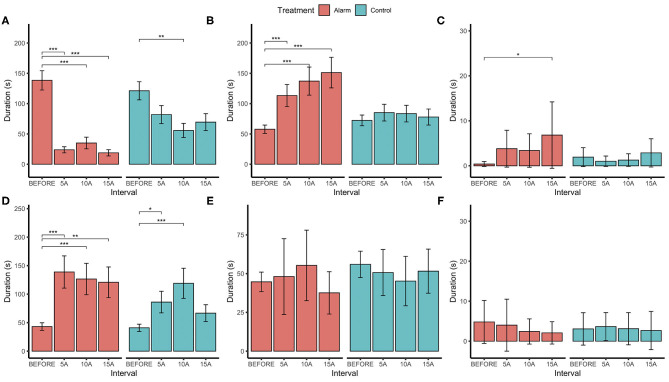
Estimated marginal means (±SE) for durations (in seconds) of (A) activity, (B) stationary, (C) social behaviors, (D) preening, (E) foraging, and (F) brooding behaviors before the stimulus (BEFORE) and in 5-min sample intervals after (5A = 0–5 min; 10A = 5–10 min; and 15A = 10–15 min) for both the alarm exposed and control groups. *p < 0.05, **p < 0.01, ***p < 0.001.